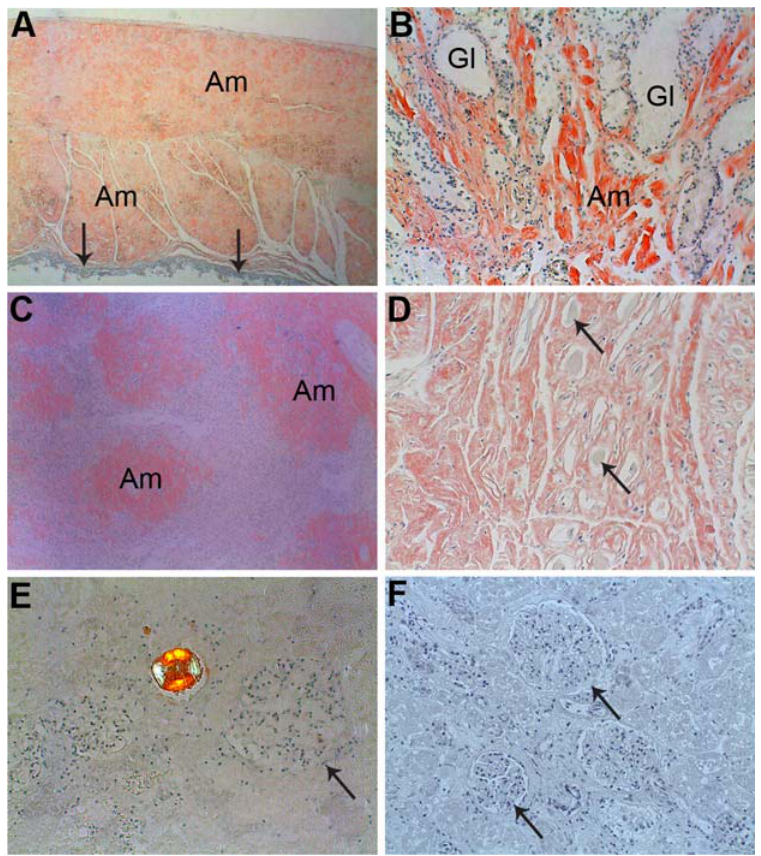
Figure 2. Demonstration of the variation in deposition pattern in the different organs. A. Cross-section of small intestine of AL312. The muscularis propria is converted into amyloid masses (Am). The mucosa is indicated by arrows. B. Section from the stomach of AL Es305 showing large amounts of amyloid between glands (Gl). C. Section of the spleen of AL90. Amyloid (Am) is seen distributed mainly in follicles. D. Section of the tongue of AL Es305 showing large amounts of amyloid. Residual striated muscle fibers (arrows) are seen. E. Kidney section of AL90. The glomeruli (arrow) are virtually free of amyloid. There is a tubular amyloid cast in the middle of the figure. F. Kidney section of AL Es305. The glomeruli (arrows) are free of